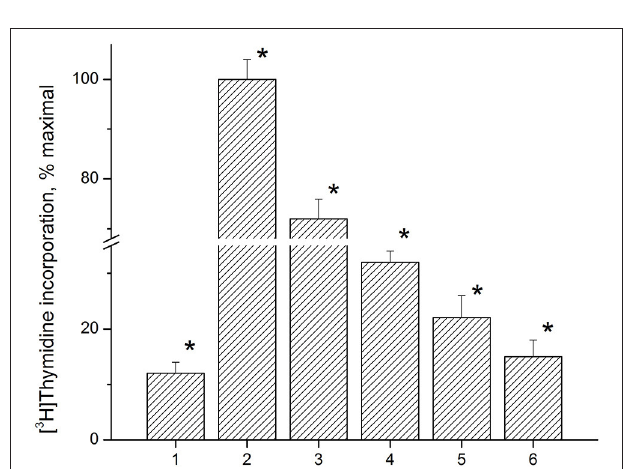
FIGURE 4 | Analysis of anti-proliferative activity of immunocortin on LN lymphocytes from EAE rats stimulated with ConA and MBP(63–81). 1, negative control, non-stimulated LN lymphocytes; 2, proliferation of LN lymphocytes stimulated with ConA (5 µ g/ml); 3, proliferation of LN lymphocytes stimulated with ConA (5 µ g/ml) in the presence of immunocortin (10 µ M); 4, proliferation of LN lymphocytes stimulated with 5 µ M MBP(63–81); 5, proliferation of LN lymphocytes stimulated with 5 µ M MBP(63–81) in the presence of immunocortin (1 µ M); 6, proliferation of LN lymphocytes stimulated with 5 µ M MBP(63–81) in the presence of immunocortin (10 µ M). Each value shown is the mean ± SEM ( n = 4).* p < 0.05, by Friedman’s